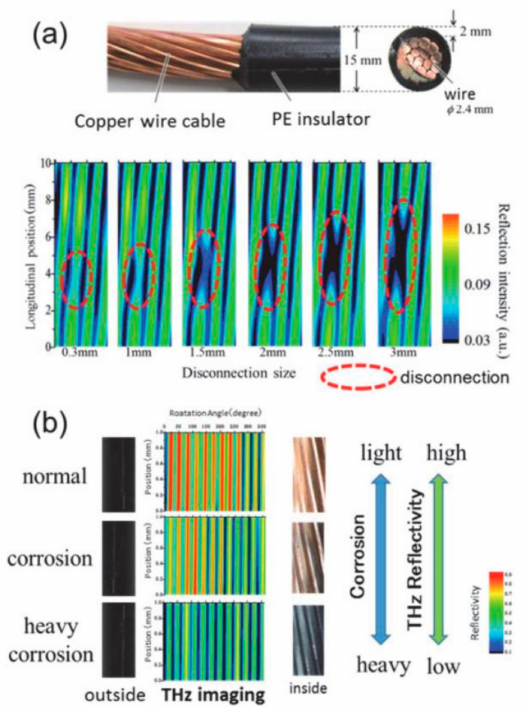
Figure 6. ( a ) Photograph of the insulated copper cable (inset) and THz reflection images of insulated cables with varying disconnection sizes; ( b ) THz reflection images of insulated cables with varying degrees of corrosion. Reproduced with permission from